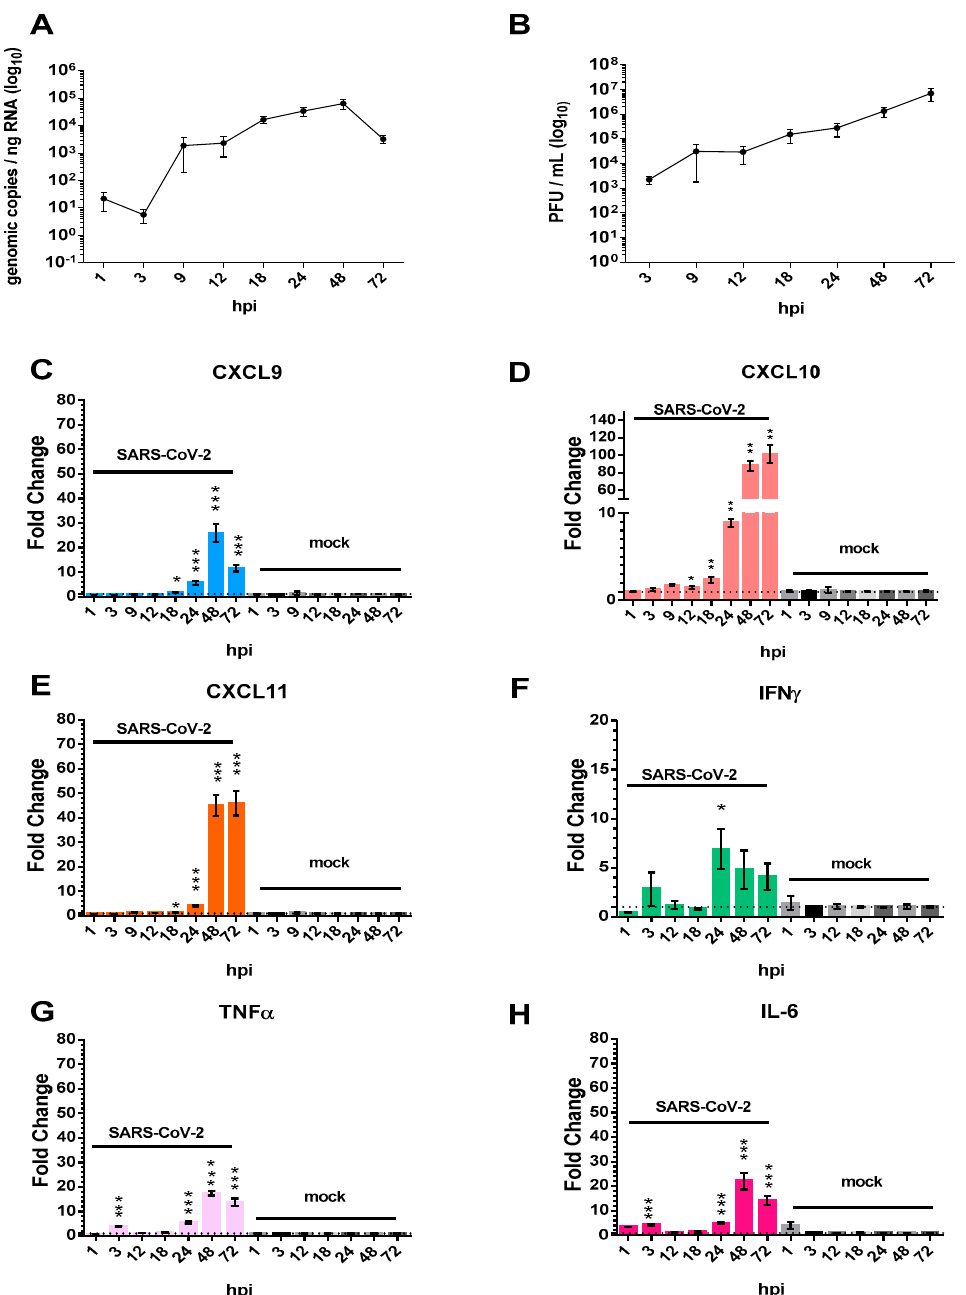
Figure 1. Pro-inflammatory chemokine/cytokine production by Calu-3 cells in response to severe acute respiratory syndrome coronavirus 2 (SARS-CoV-2) infection of Calu-3 cells. Calu-3 cells were infected with SARS-CoV-2 (MOI 1). At 1, 3, 9, 12, 18, 24, 48 and 72 h post-infection (hpi), total cell lysates were collected and subjected to RNA isolation. Supernatants were collected in parallel for viral plaque assays. ( A ) The SARS-CoV-2 viral genome copies detected by RT-qPCR ( n = 4). ( B ) Viral plaque assays were conducted and PFU/mL calculated ( n = 4). Host transcriptional-targets were detected by RT-qPCR: ( C ) CXCL9 , ( D ) CXCL10 , ( E ) CXCL11 , ( F ) IFN γ , ( G ) TNF α , and ( H ) IL-6 . Transcript levels are expressed as fold change as compared to the respective mock-infected control and represent the mean ± SEM ( n = 4). Significance was determined using the Student’s t -test; * p < 0.05, ** p < 0.001, *** p < 0.0001.